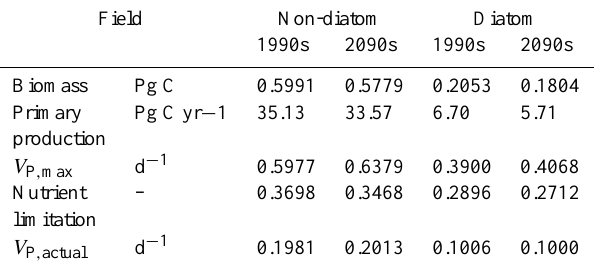
Table 1. Changes in key phytoplankton growth indicators between the 1990s and 2090s. Biomass and primary production refer to the average standing stock of phytoplankton and the production of new biomass. V P , max refers to the potential maximum growth rate of phytoplankton based on temperature- and light-limitation. Nutri- ent limitation refers to the restriction placed on this by nutrient availability. And V P , actual is the actual growth rate achieved by phytoplankton. Growth rates and nutrient limitation are biomass- weighted averages to discount the influence of large, unproductive ocean regions such as the oligotrophic gyres that have high potential growth rates, but extreme nutrient limitation and low